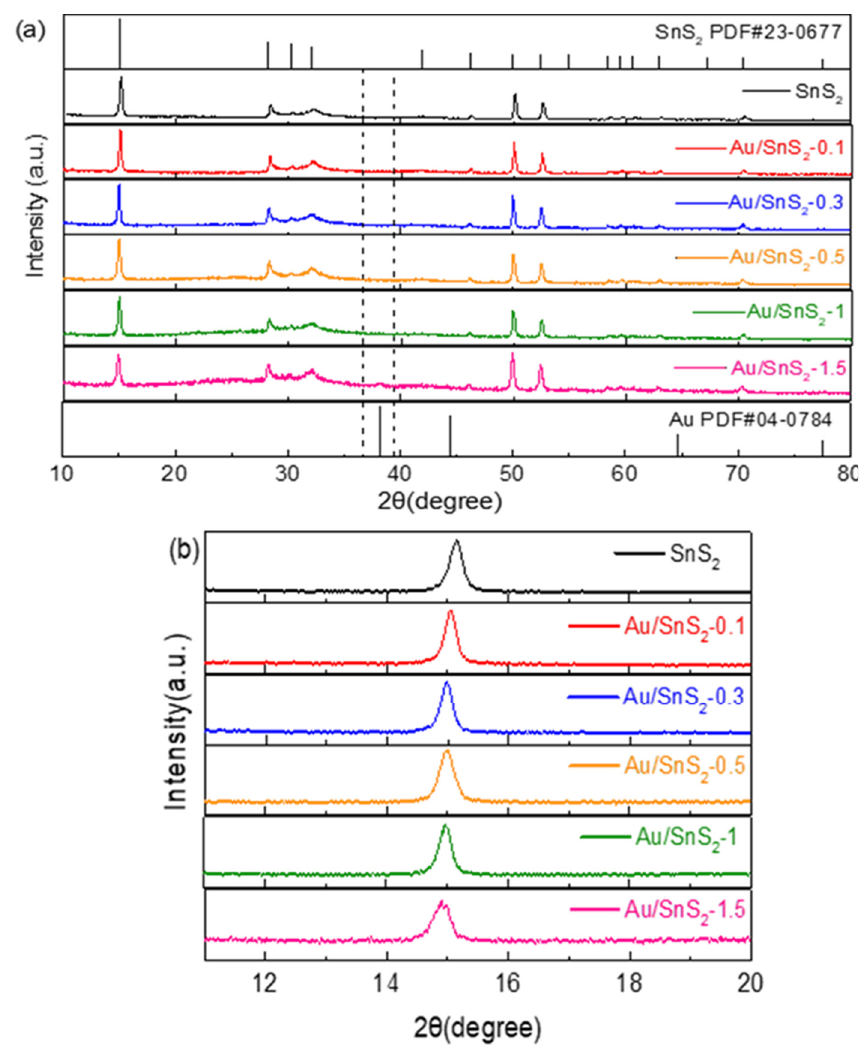
Figure 3. ( a ) XRD patterns of the prepared samples and ( b ) partial enlarged view of the XRD.